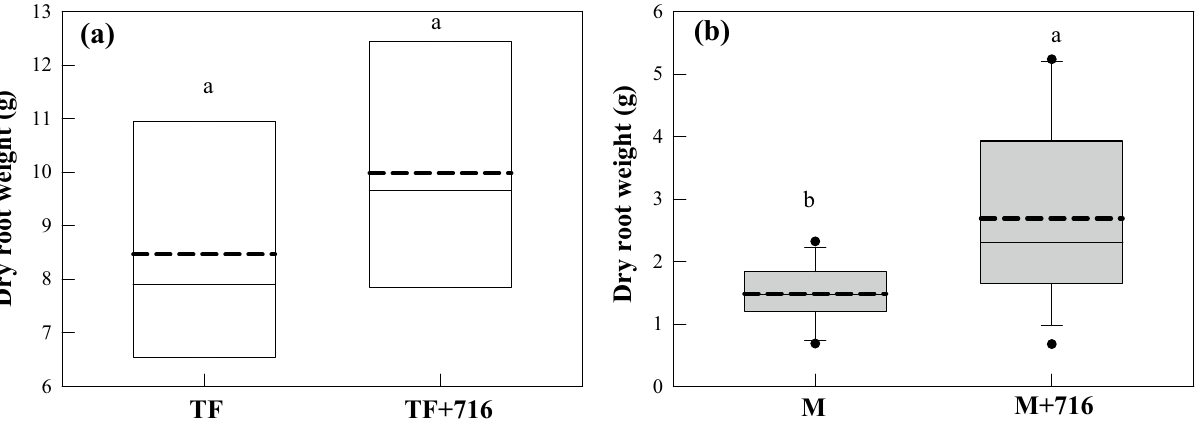
Figure 5. Inoculation effect of Pseudomonas sp. TF716 on the root growth of ( a ) tall fescue and ( b ) maize (TF: soil planted with tall fescue; TF + 716: soil planted with tall fescue with the addition of strain TF716; M: soil planted with maize; M + 716: soil planted with maize with the addition of strain TF716). In the box plots, the boxes represent the 25th, 50th, and 75th percentiles, and the error bars indicate the 5th and 95th percentiles. Points outside the boxes indicate outliers. The dashed line indicates the median. Different letters indicate a significant difference in each plot ( p <